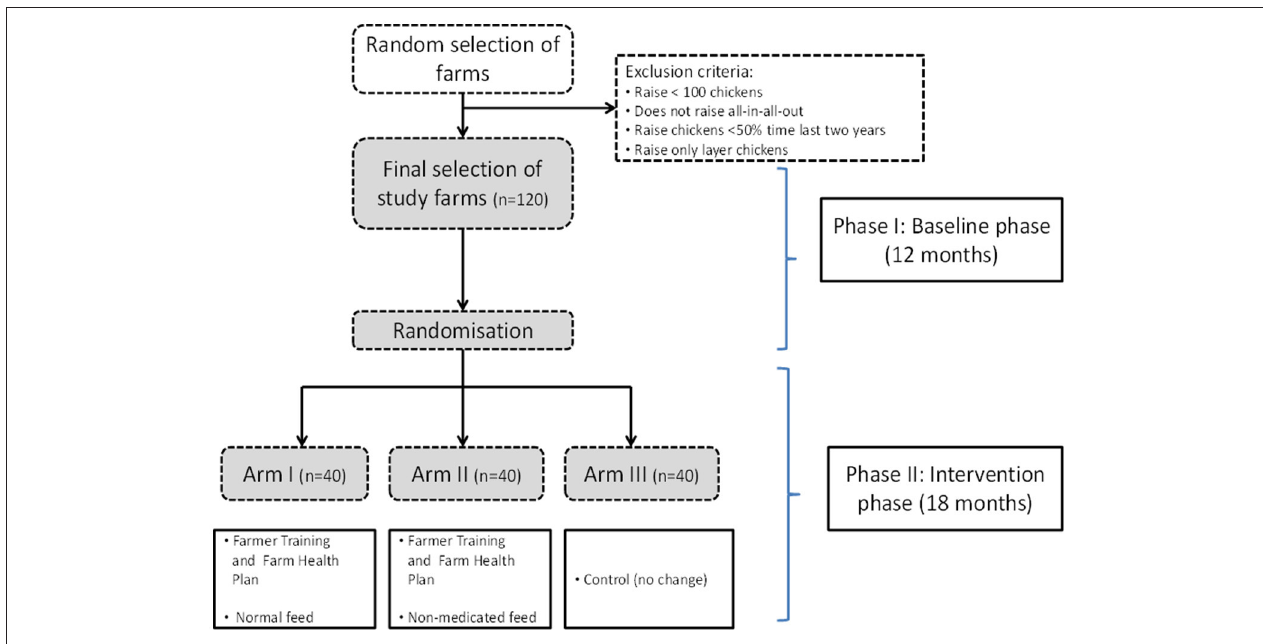
FIGURE 1 | Study design of the ViParc intervention study.